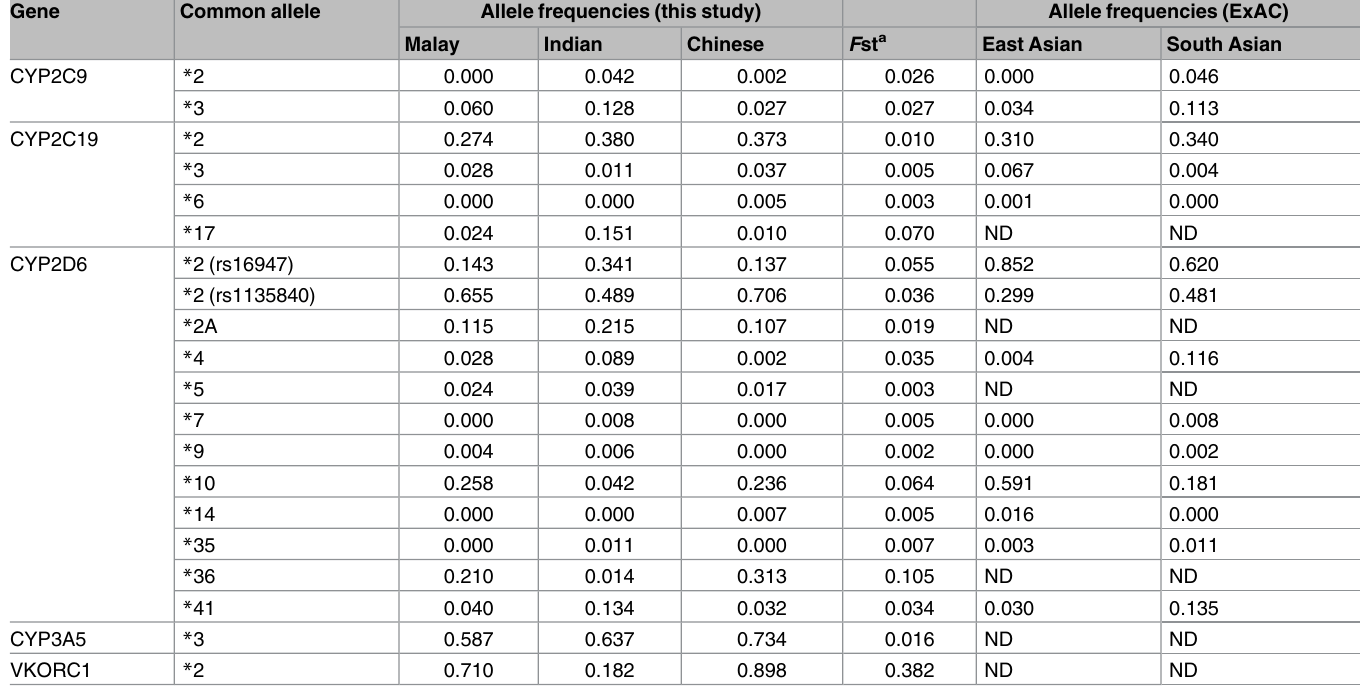
Table 3. Allele frequencies in Malay, Chinese and Indian